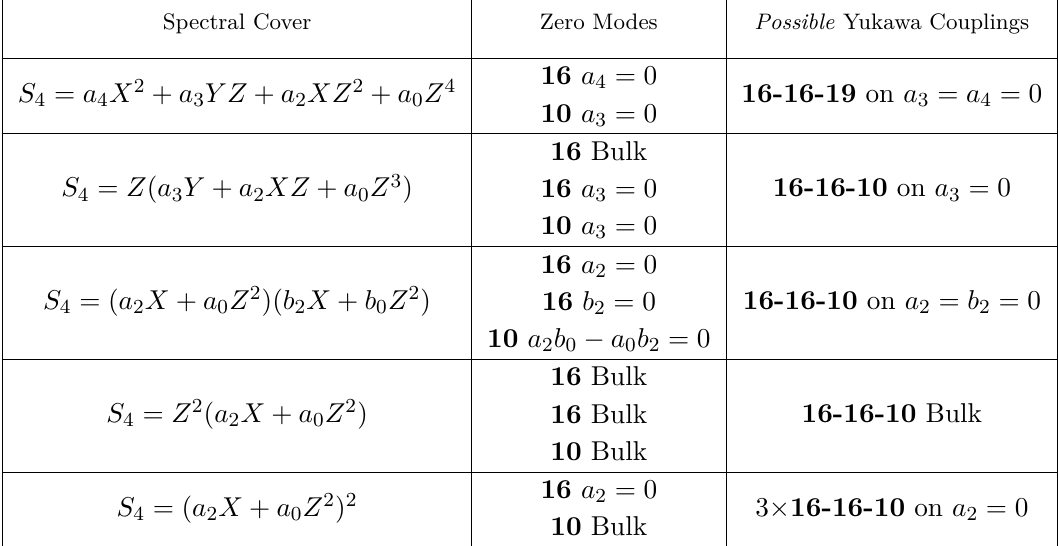
JHEP11(2021)131